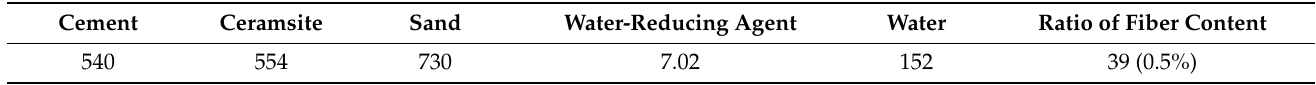
Table 6. Mixed proportion of ceramsite concrete beam specimens (Unit: kg/m 3 ).